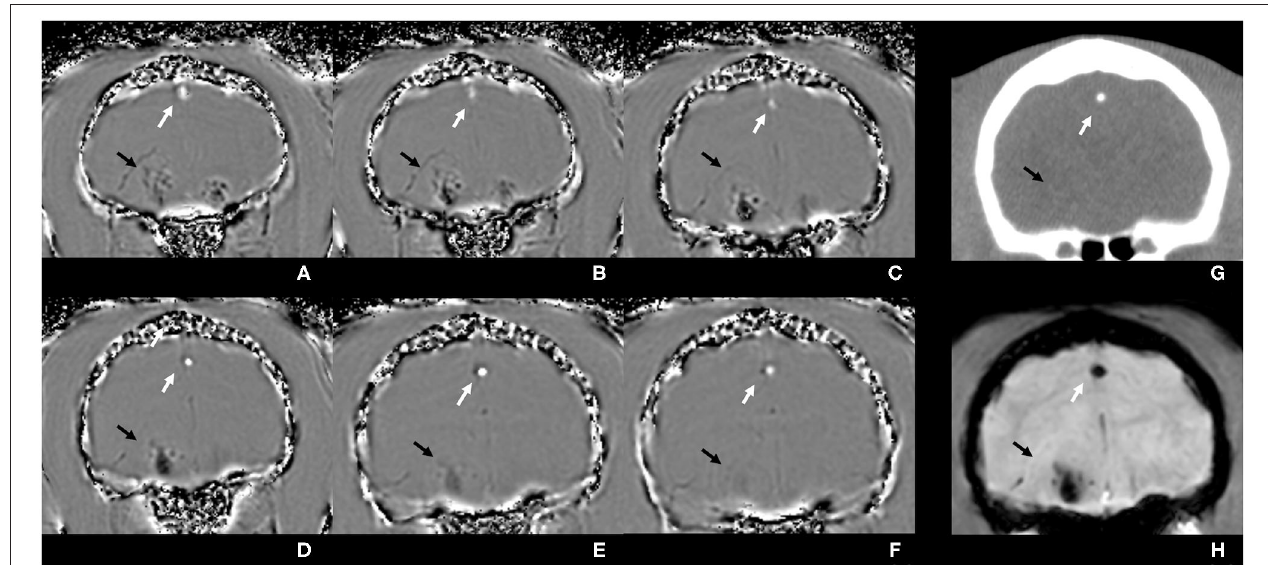
FIGURE 2 | Susceptibility-weighted phase images (A–F) of the brain of a cat from the level of the frontal lobes to the level of the tympanic bullae, illustrating signal intensity differences between diamagnetic and paramagnetic tissues. The calcified falx cerebri, diamagnetic, is depicted to be predominantly hyperintense (white arrows), whereas the intracranial hemorrhagic lesion, paramagnetic, is heterogeneous and predominantly hypointense (black arrows). Corresponding CT image in a soft tissue algorithm (G) : calcification is highly hyperattenuating (white arrow), and the hemorrhage is iso- to hyperattenuating compared with the brain parenchyma (black arrow). In the susceptibility-weighted magnitude image (H) , both lesions have hypointense signal intensity.